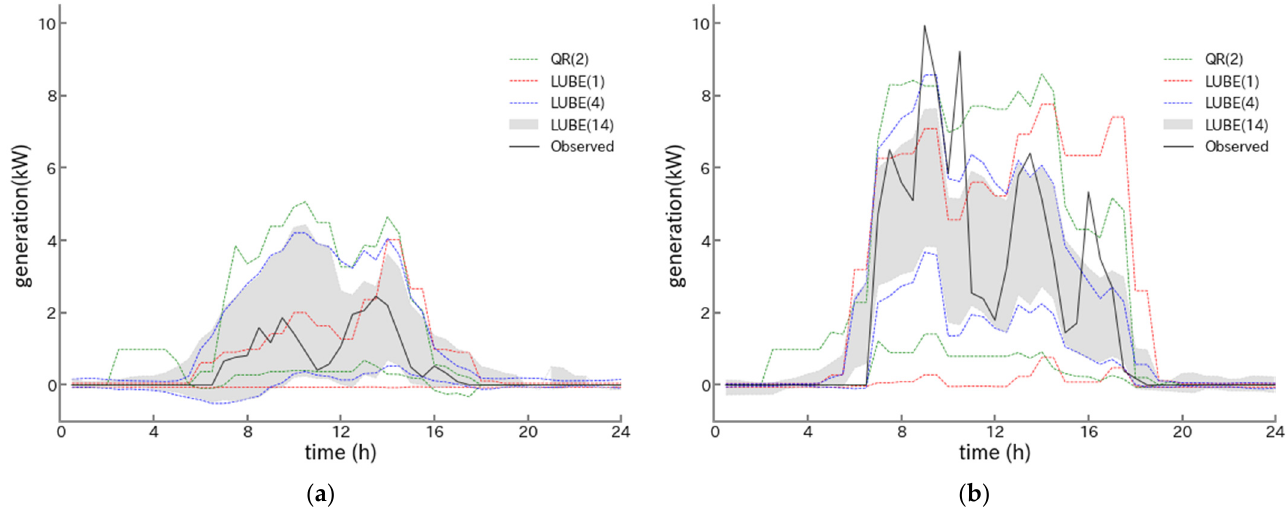
Figure 12. Prediction intervals for LUBE(1), (4), (14), and QR(2): ( a ) 6 June, the day with the smallest output fluctuation in two weeks.; ( b ) 9 June, the day of the largest output fluctuation in two weeks.